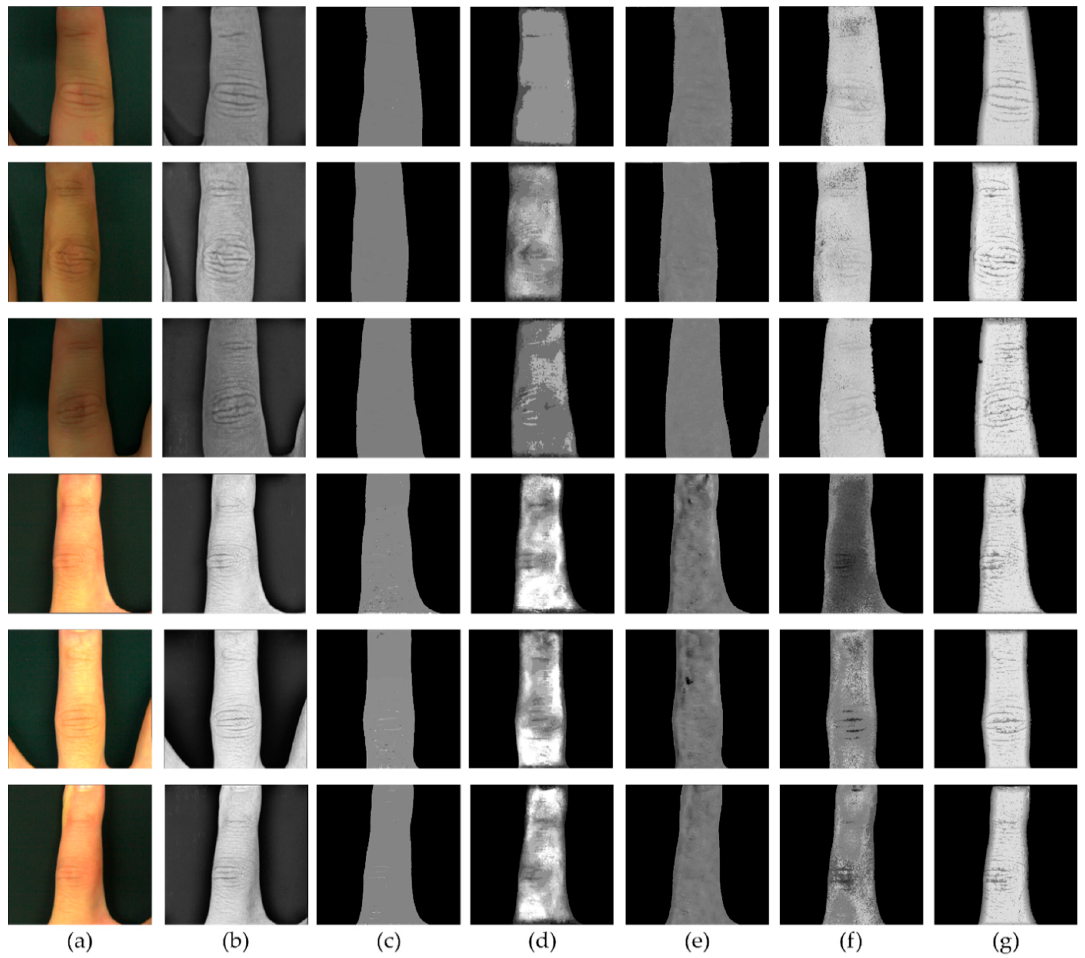
Figure 10. The qualitative comparison results with state-of-the-art depth estimation methods: ( a ) center view images taken under natural illumination; ( b ) the illumination-insensitive and texture-enhanced images obtained from proposed method; ( c , d ) shows estimated disparity maps from ( c ) Wang [23]; ( d ) Jeon [18]; ( e ) Zhang [26]; ( f ) Williem [20]; ( g ) our method.